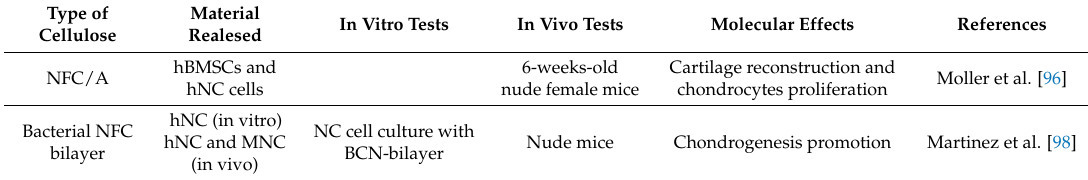
Table 4. Summary of the nano cellulose-based materials tested in cartilage